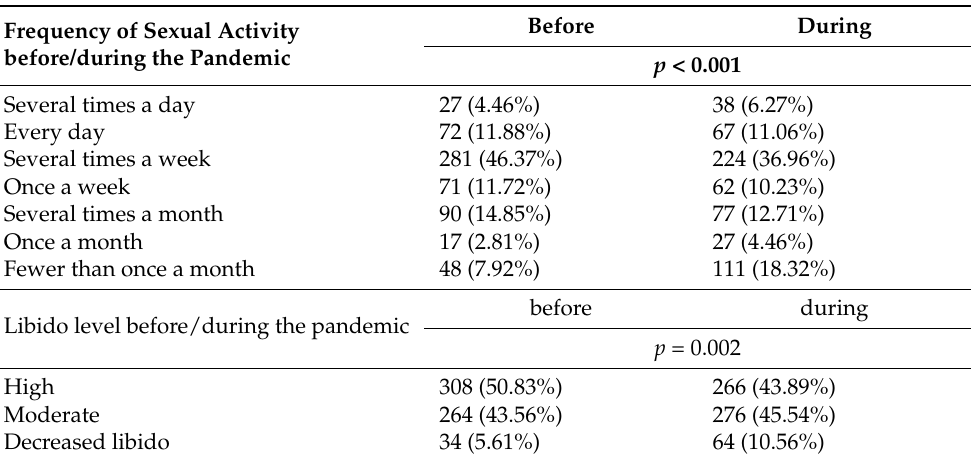
Table 3. Sexual activity and libido levels before and during the pandemic. Frequency of Sexual Activity